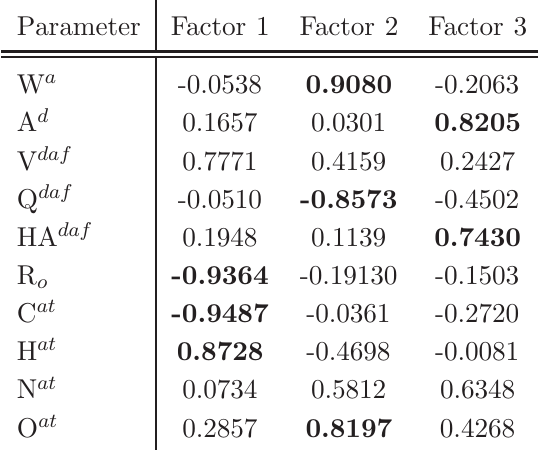
Table 2 The factor loadings after Varimax